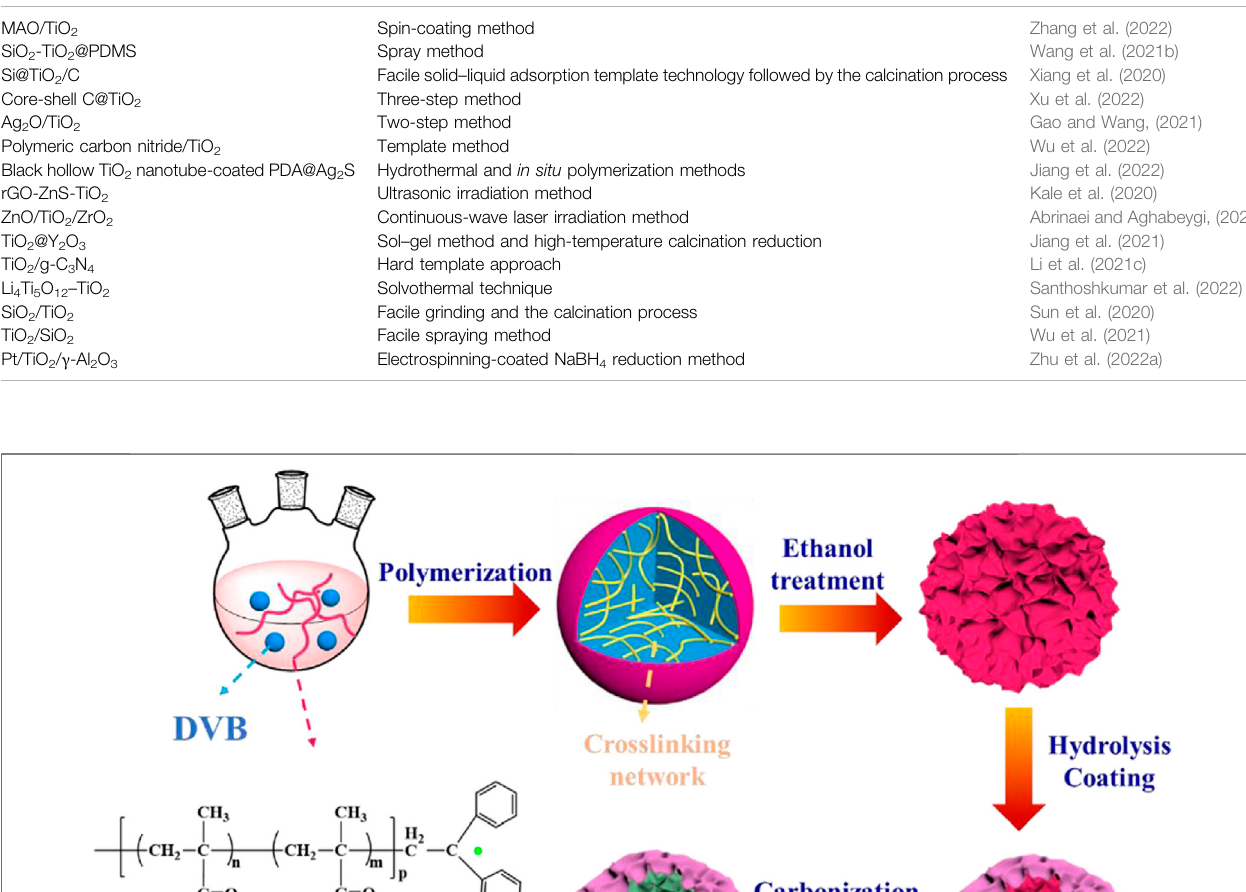
TABLE 1 | Preparation method of micro/nanostructured TiO Catalyst